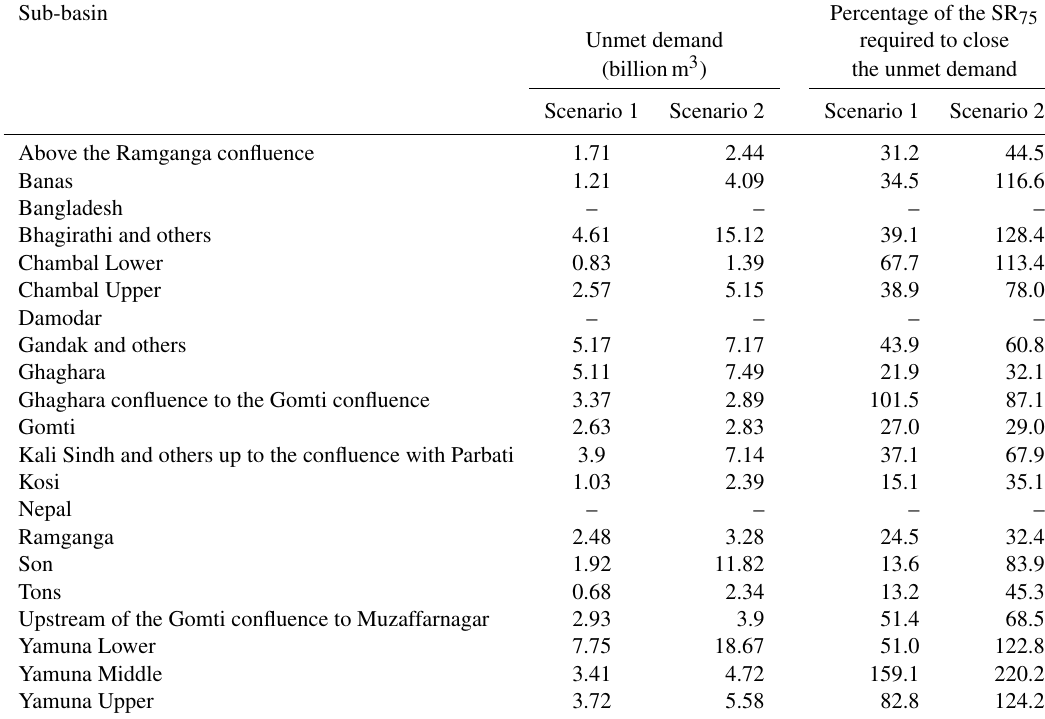
Table 4. Sub-basin-wise unmet agricultural water demand and the percentage of runoff required to close the unmet demand.